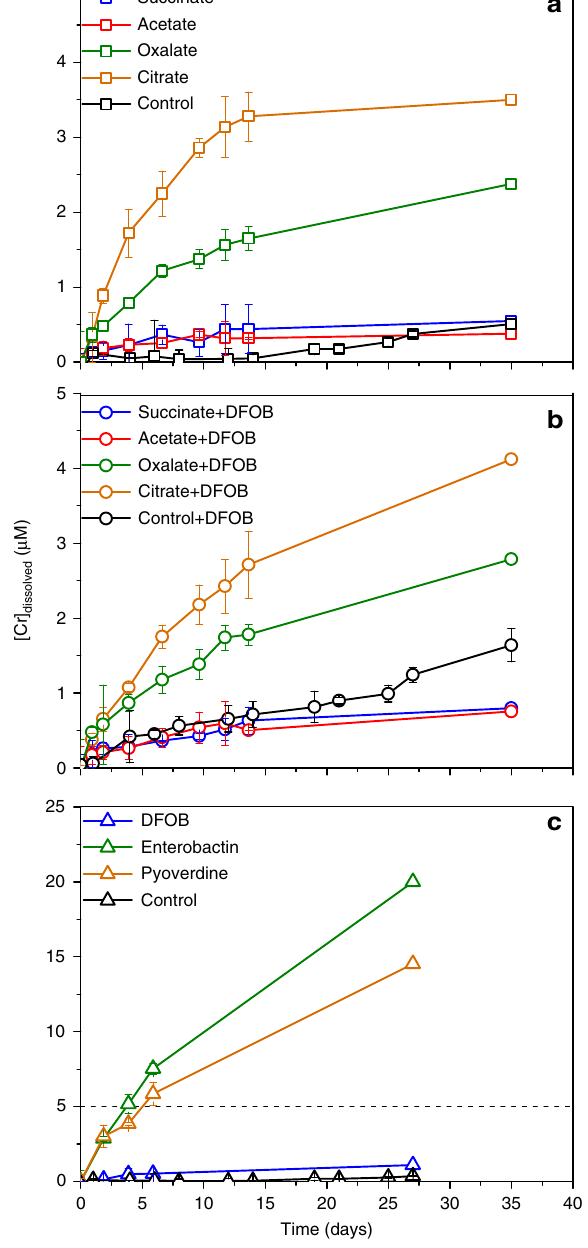
Fig. 1 Cr dissolution pro fi le in the presence of different ligands. Dissolved Cr concentrations in the presence of a organic acids only, b organic acids and the siderophore, desferrioxamine B (DFOB), and c siderophores only. Experimental conditions are 0.2 g l − 1 of Cr(OH) 3 at pH 7 (10 mM HEPES), and ionic strength of 0.1 M. Error bars represent the standard deviation between replicates. The dashed line in ( c ) indicates the maximum value of the y -axis in ( a ) and ( b ). All dissolved Cr was determined to be in the +3